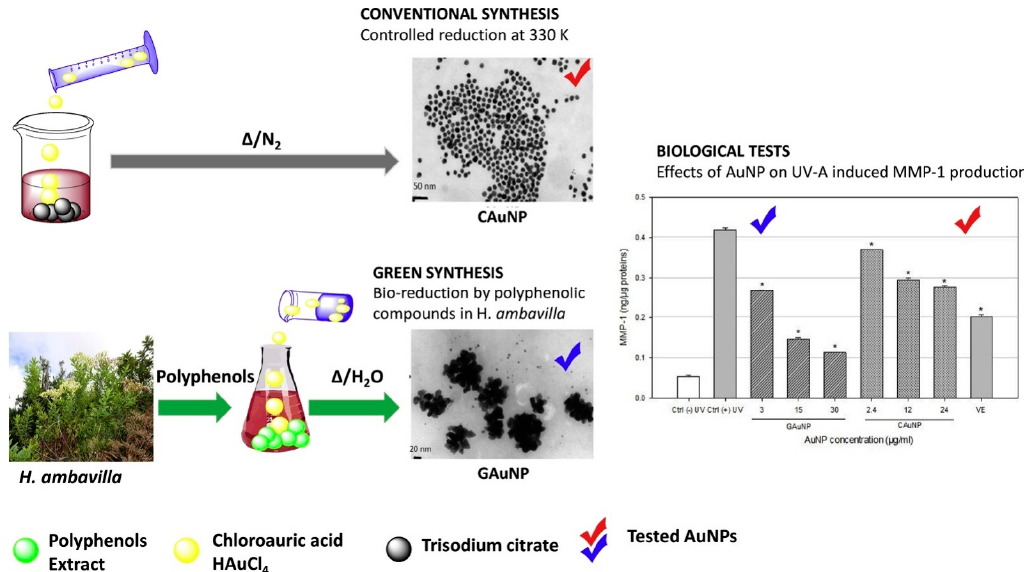
Figure 6. Green synthesis of gold nanoparticles and their antioxidant and dermo-protective activities as a safe cosmetic ingredient. Reprinted from Haddada et al. [49] with permission from Elsevier. Copyright (2020) Elsevier B.V.